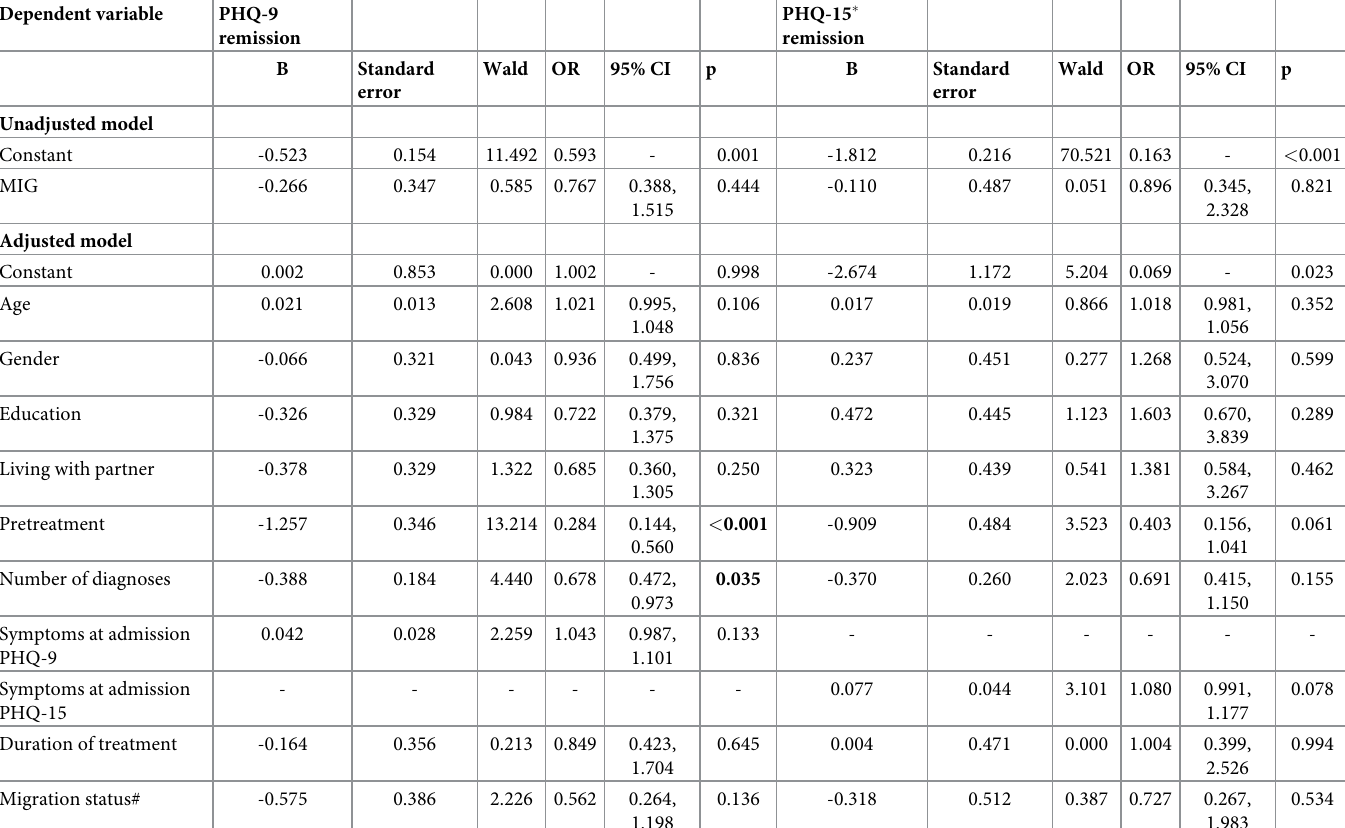
Table 3. Results of multiple binary logistic regression analysis for remission at discharge